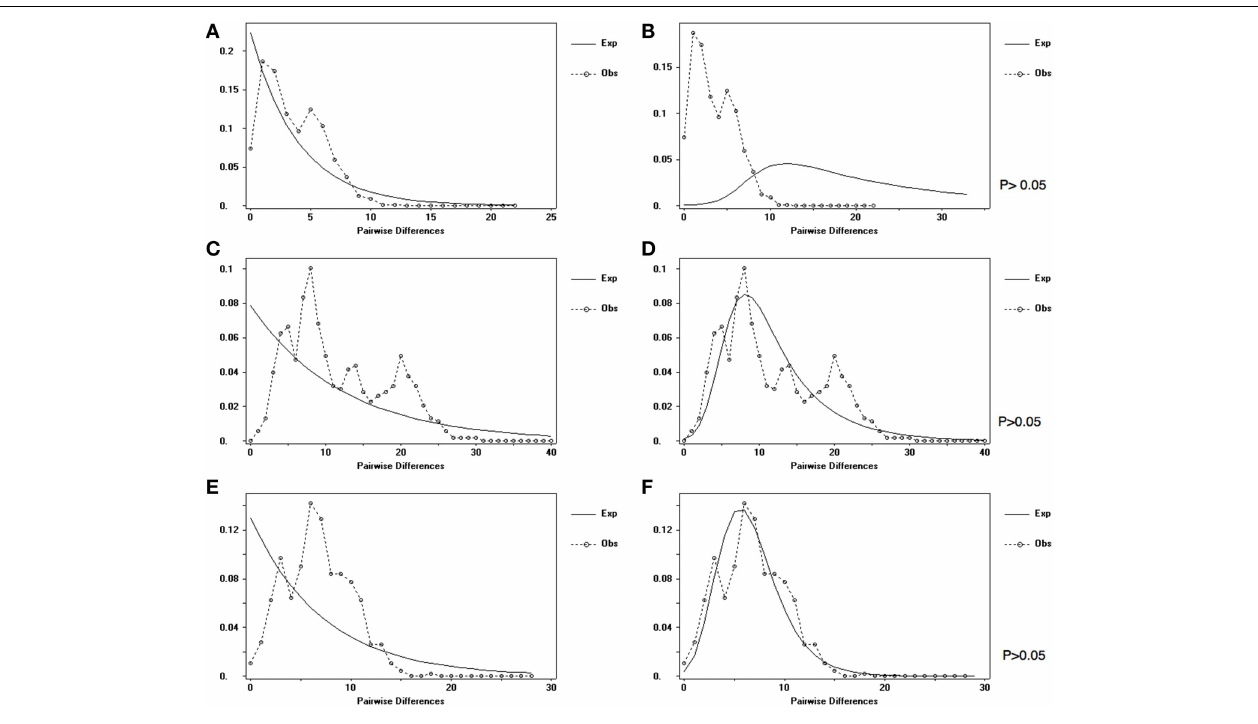
growth (B,D,F) for O. carinifera (A,B), O. lymani from the Patagonian Shelf (C,D) and O. lymani from the South Georgia shelf